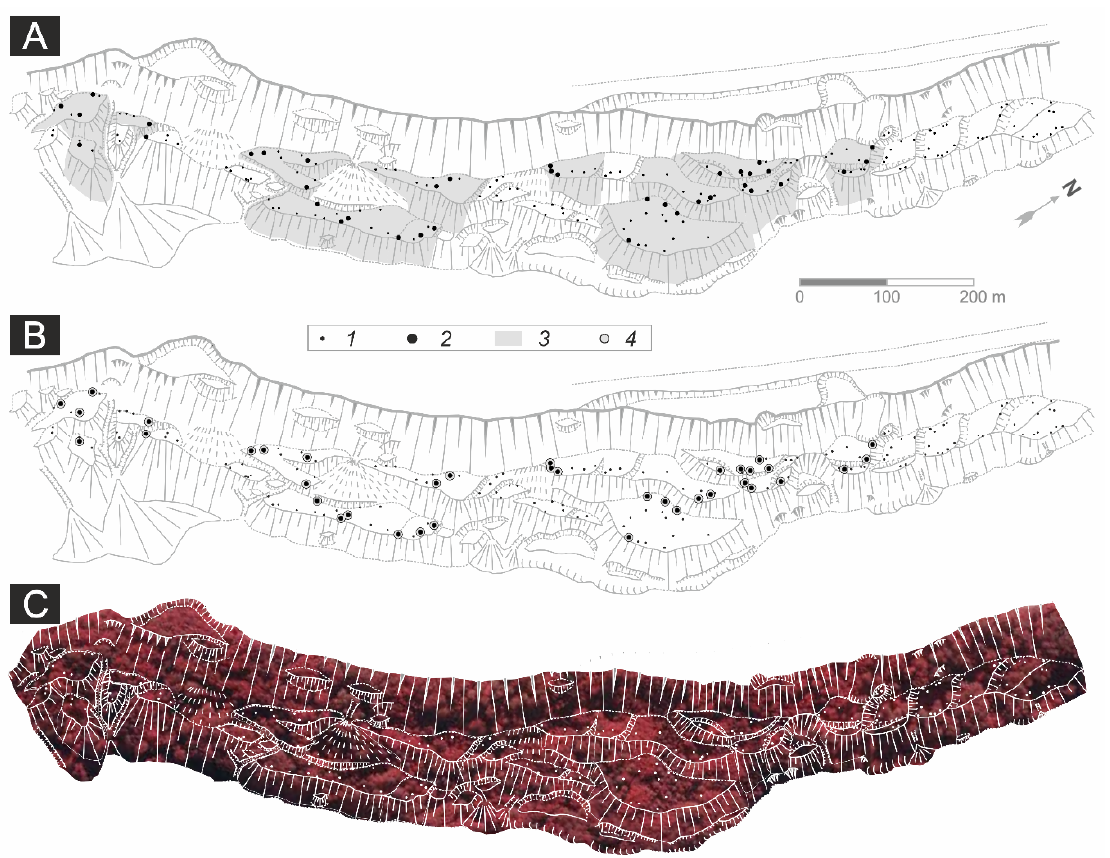
Figure 7. The area affected by landslide reactivation in a case year 1997 based on homogenous morphological units ( A ) and tree buffers ( B ), and the afforestation of the Lipová stráň landslide area ( C ) based on the infrared picture (1 – position of sampled trees, 2 – position of trees with landslide signal in a particular year, 3 – reactivated area during a particular event, 4 – tree buffer).